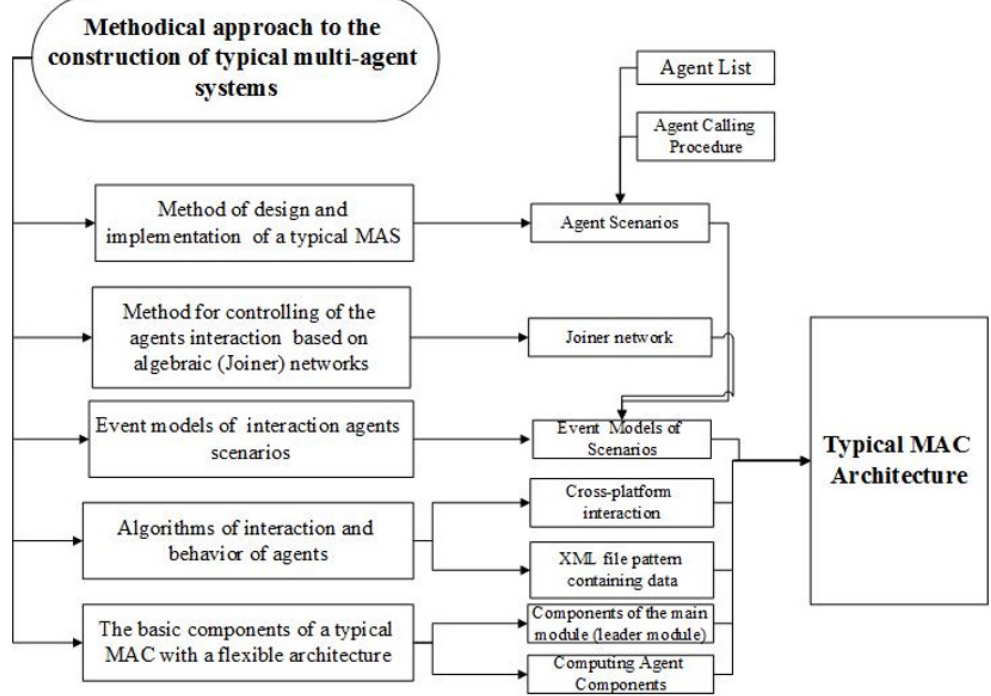
Fig. 3. Methodical approach to the construction of multi-agent